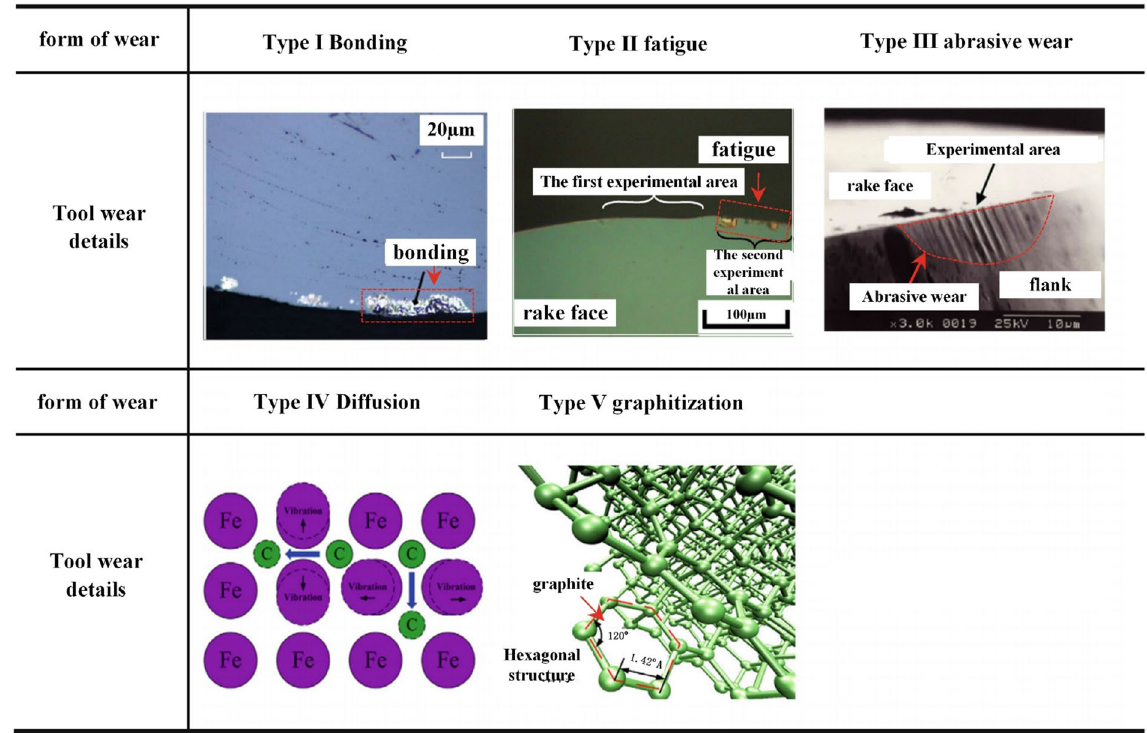
Fig. 4 Common form of tool wear mechanism